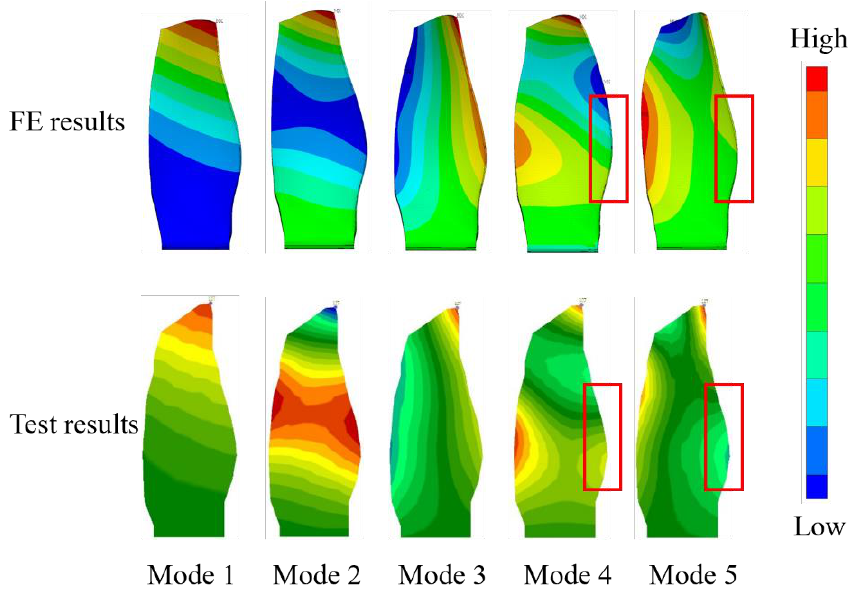
Figure 4. The first five mode shapes.